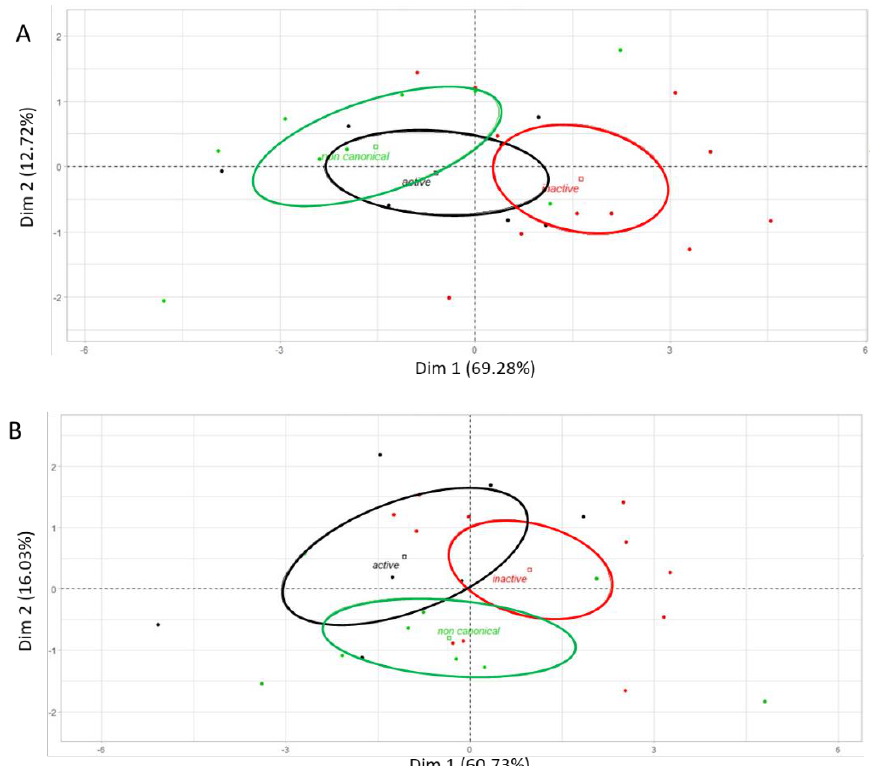
Figure 4. Principal component analysis of rhoptry kinase transcription according to their activity status in Et INRAE ( A ) and Et WIS ( B ) strains. Active kinases are represented in black, inactive in red, and non-canonical in green.